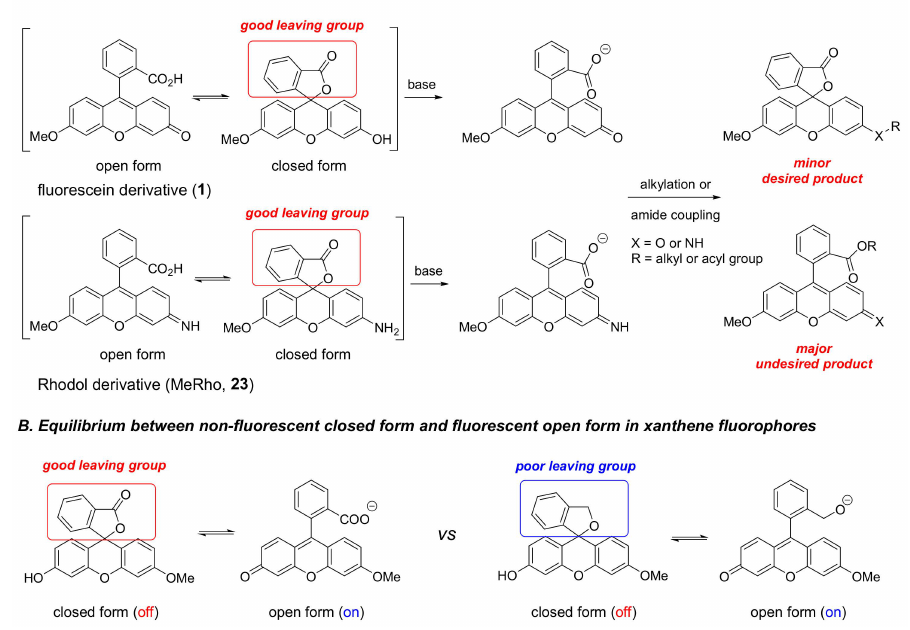
Figure 1. Structural analysis of typical and reduced xanthene fluorophores. ( A ) Reactivity of fluorescein and rhodol derivatives in alkylation and amide coupling reactions; and ( B ) equilibrium between closed and open forms a ff ecting